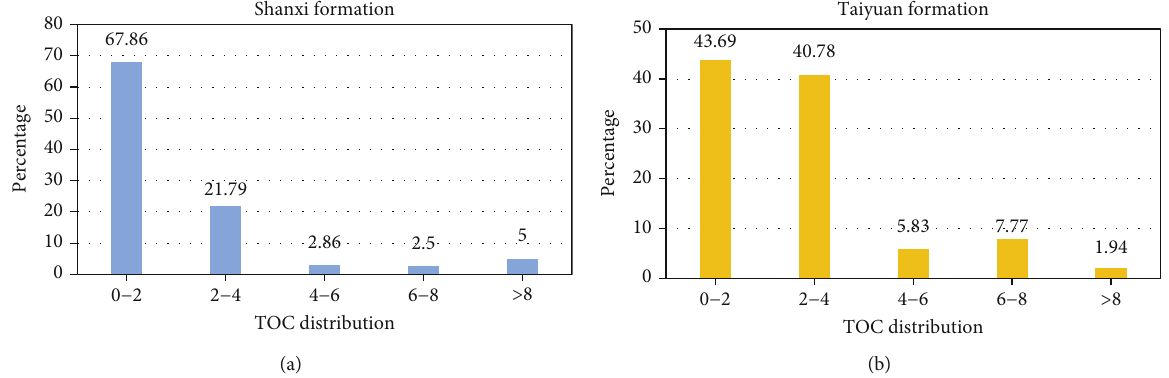
Figure 3: The total organic carbon content of the mud (shale) stone reservoirs in the study area.